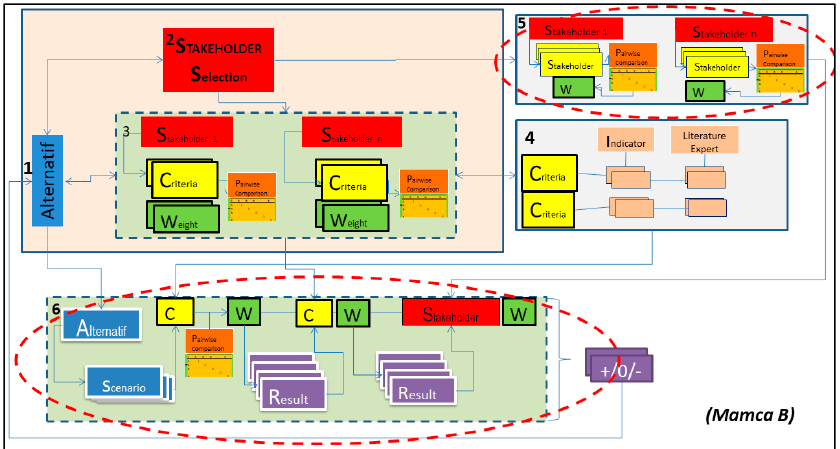
Figure 4. Multi-actor multi-criteria analysis based on the weight of stakeholder involvement (method B).